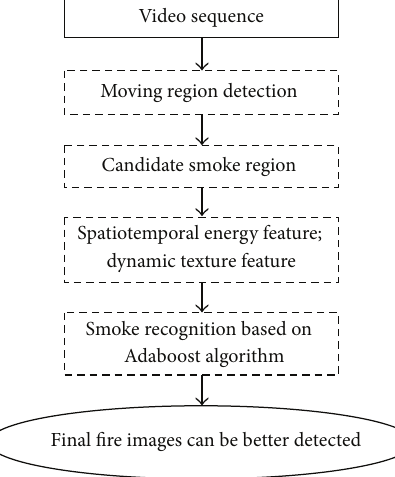
Figure 1: The basic process of the proposed scheme. of early smoke of forest fire are extracted in terms of flutter analysis, energy analysis, and color analysis. Motion regions in terms of Section 2.1 are divided into blocks of the size 8 × 8.